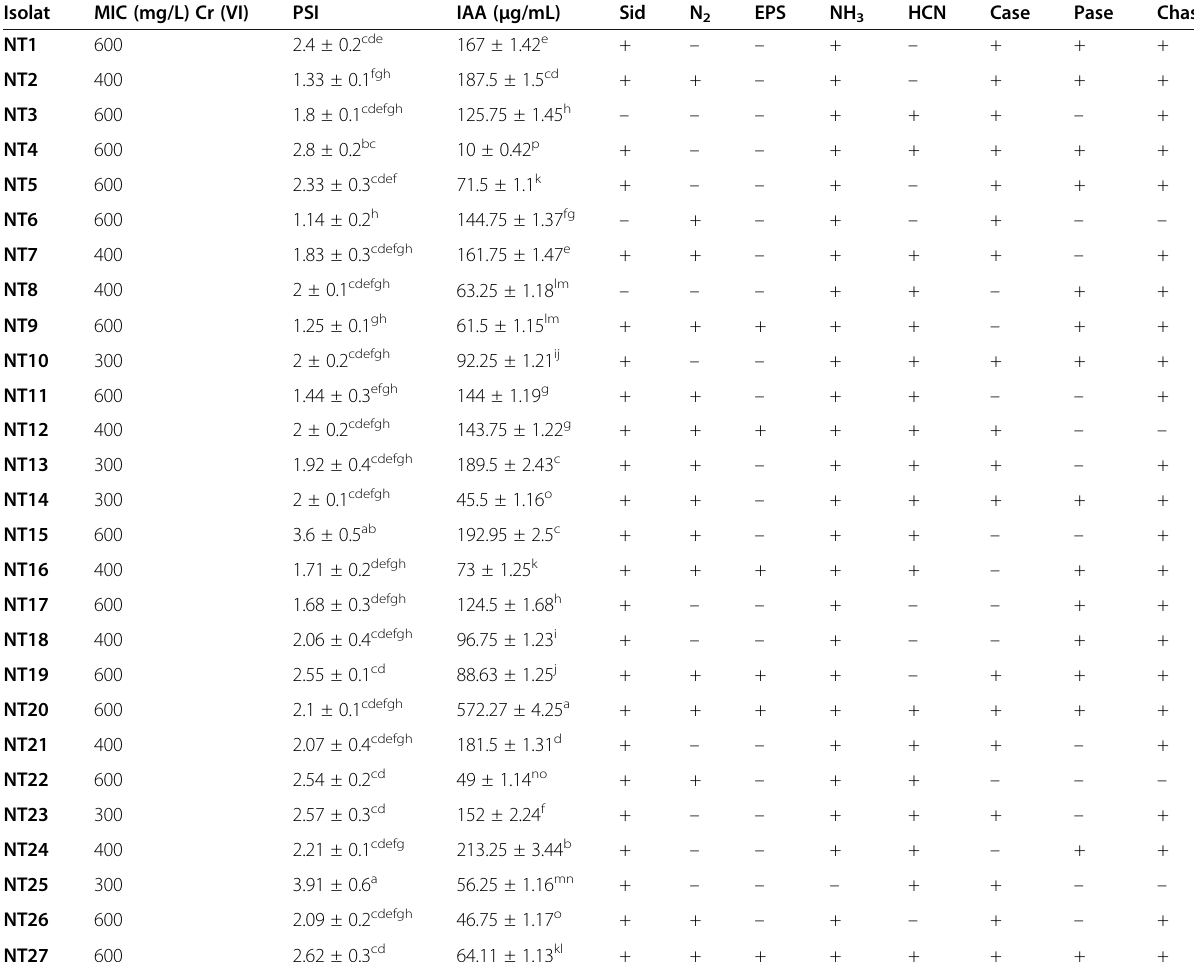
Table 1 Minimum inhibitory concentrations (MIC) of Cr (VI) and plant growth-promoting (PGP) traits of the bacterial isolates. Data are the mean of replicates with SE ±. Values with different letters are significantly different ( p < 0.05)